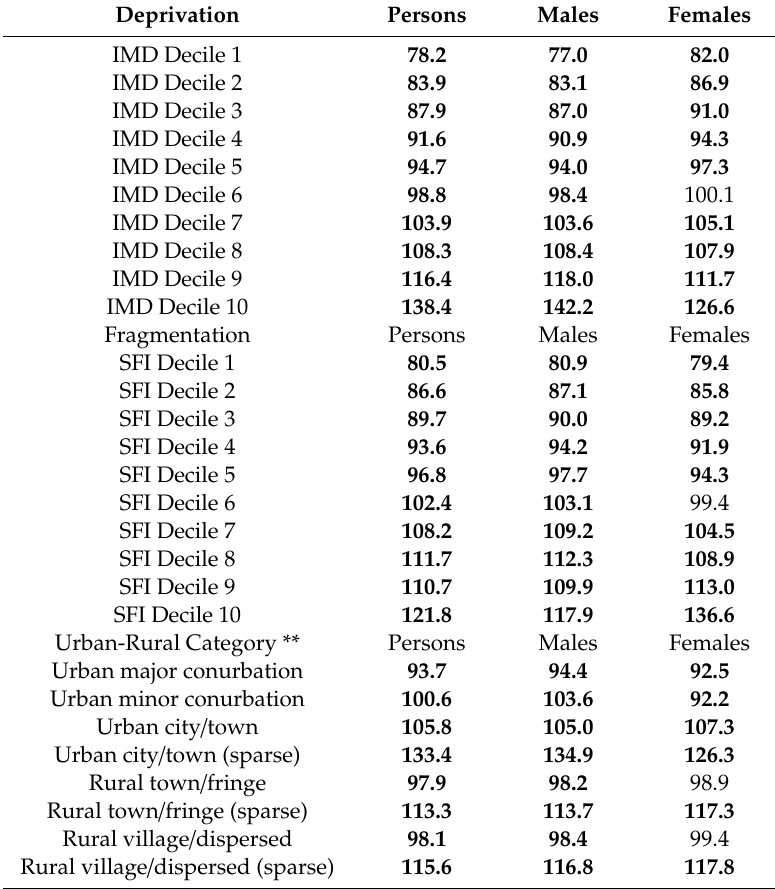
Table 6. Estimated Standard Mortality Ratios,